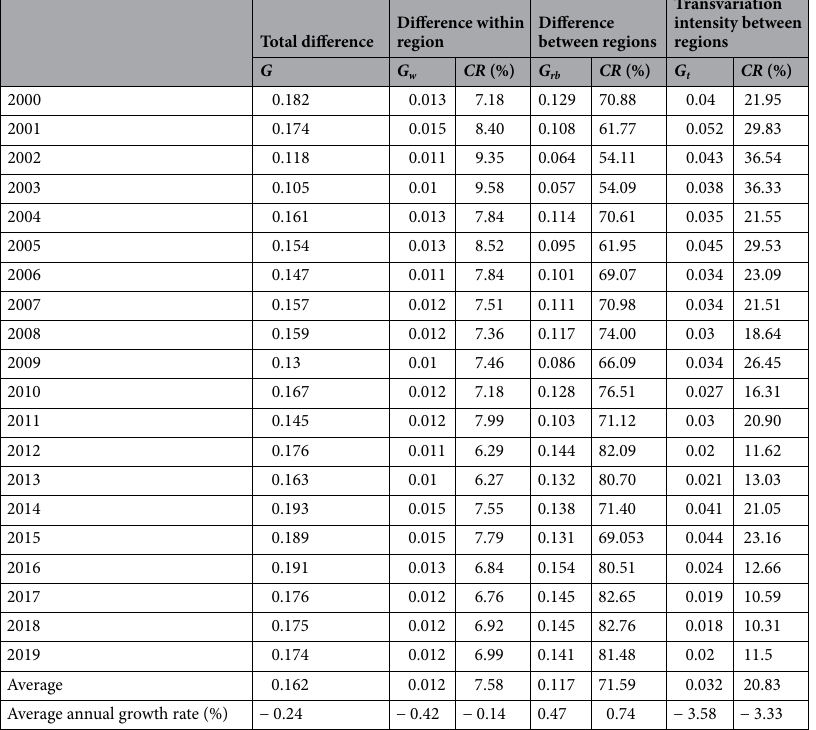
Table 6. The contributions to the total difference of CEEIE.